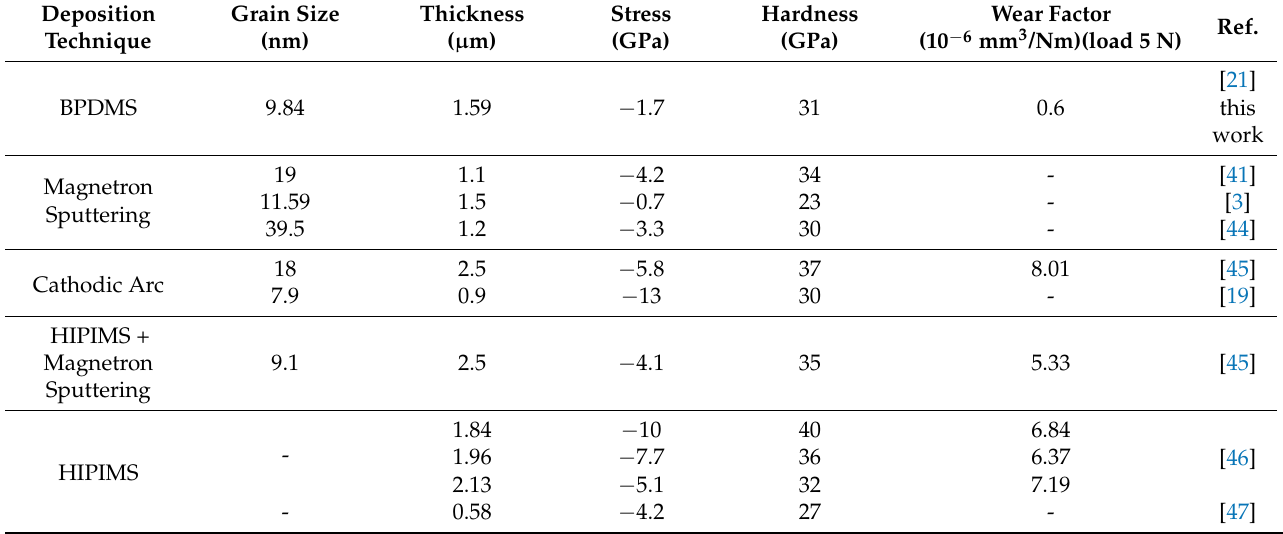
Table 3. Grain size, thickness, stress, hardness, and wear factor of ZrN thin films deposited through alternative types of sputtering methods, recently published, in comparison to the results obtained in present